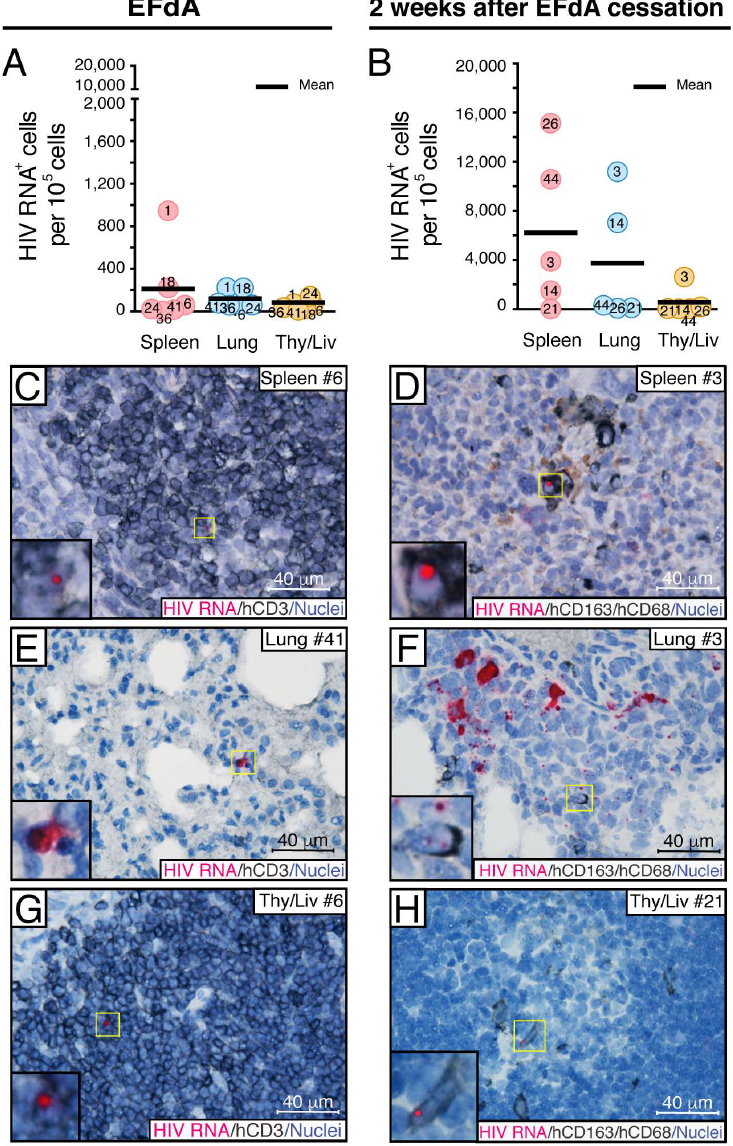
Figure 4. Identification of HIV RNA + cellular compartments in the spleen, lung, and Thy/Liv implant of NSG-BLT mice during fully suppressive EFdA treatment and after drug cessation. HIV RNA + cells were detected by RNAscope ISH using a HIV- gag-pol antisense probe in NSG-BLT mouse spleens, lungs, and Thy/Liv implants at the time of EFdA cessation ( A , C , E , G ) and 2 weeks later ( B , D , F , H ). The results are representative of 3 RNAscope assays with 3 tissue sections per organ. ( A , B ) Fifty images of representative region containing human lymphoid and myeloid cells were acquired at a magnification of 630 × for each organ. HIV RNA + cells were enumerated by ImageJ software and expressed per 10 5 cells. The mean value for each organ is represented in panels ( A ) and ( B ). The Mann − Whitney U-test performed the statistical comparison between organs at the same time point and was not significant ( P > 0.05). Phenotyping of HIV RNA + cells was accomplished by combined RNAscope ISH and chromogenic immunohistochemistry for human T-cell hCD3 ( C , E , G ) and human macrophage markers hCD163 and hCD68 ( D , F , H ). Panels ( C , E ), and ( G ) show representative images of organs from EFdA-suppressed mice, and panels ( D , F ), and ( H ) show representative images of organs from mice 2 weeks after EFdA cessation. Organ numbers in ( C – H ) indicate mouse numbers in panels ( A ) and ( B ). HIV RNA in the insets in panels ( C , D , G ), and ( H ) was visualized by alkaline phosphatase-Fast Red fluorescence detection. Nuclei were counterstained with hematoxylin. Yellow ( C – H ) rectangles show regions magnified in the